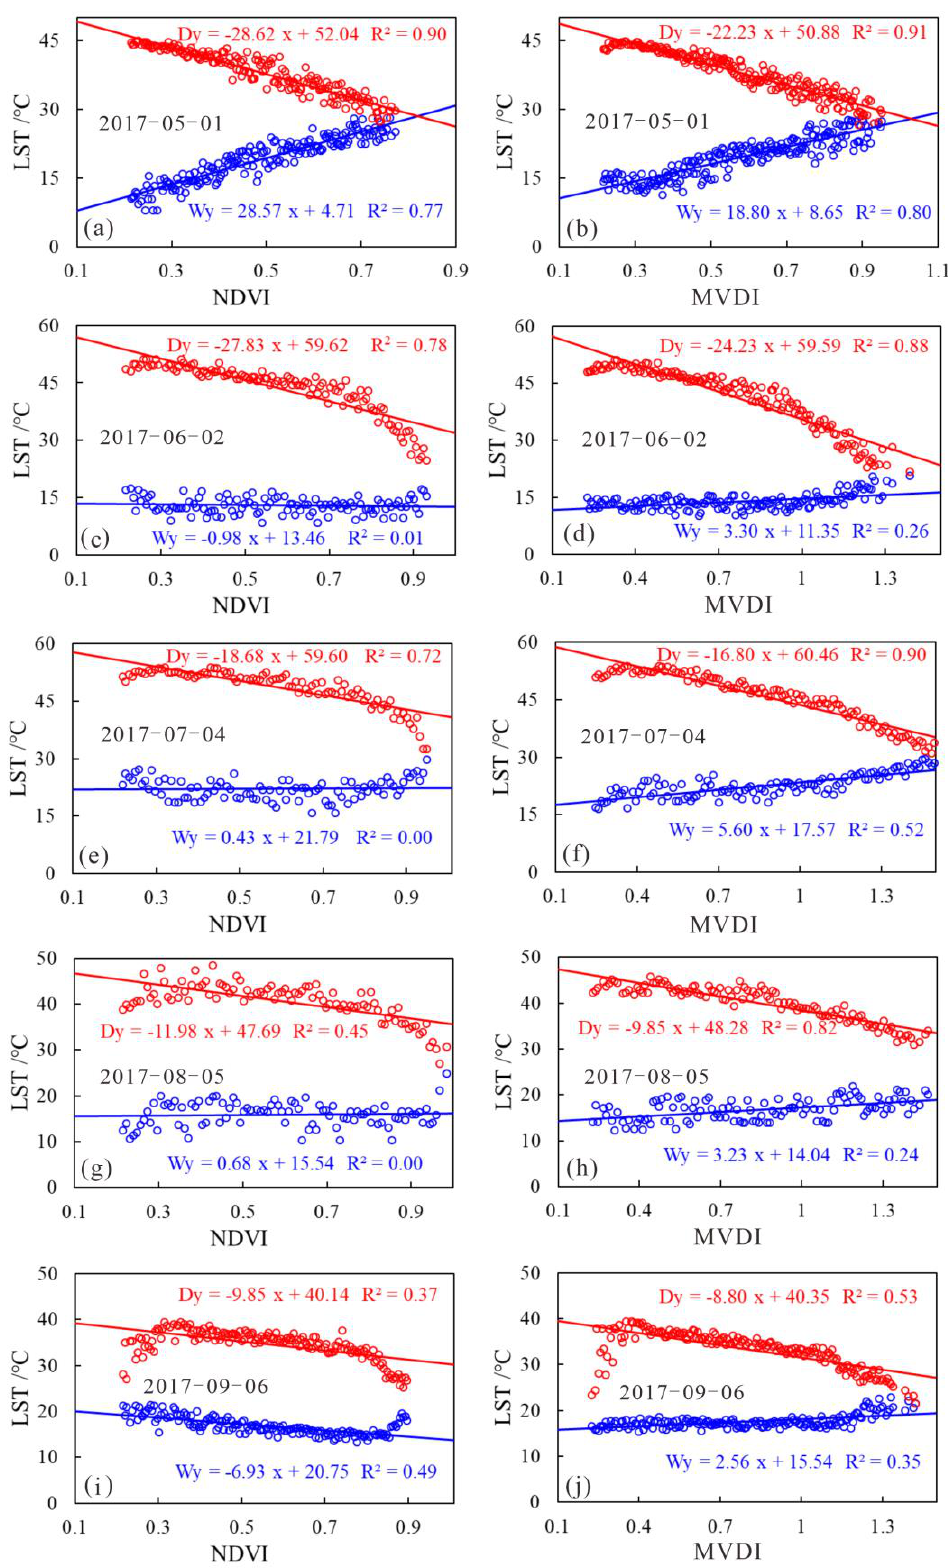
Figure 8. The feature spaces of the TVDI and mTVDI in Northeast China during the growing season (May–September) of 2017. ( a , c , e , g , i ) Dry and wet edges of the NDVI–LST feature space; and ( b , d , f , h , j ) dry and wet edges of the MVDI–LST feature space.